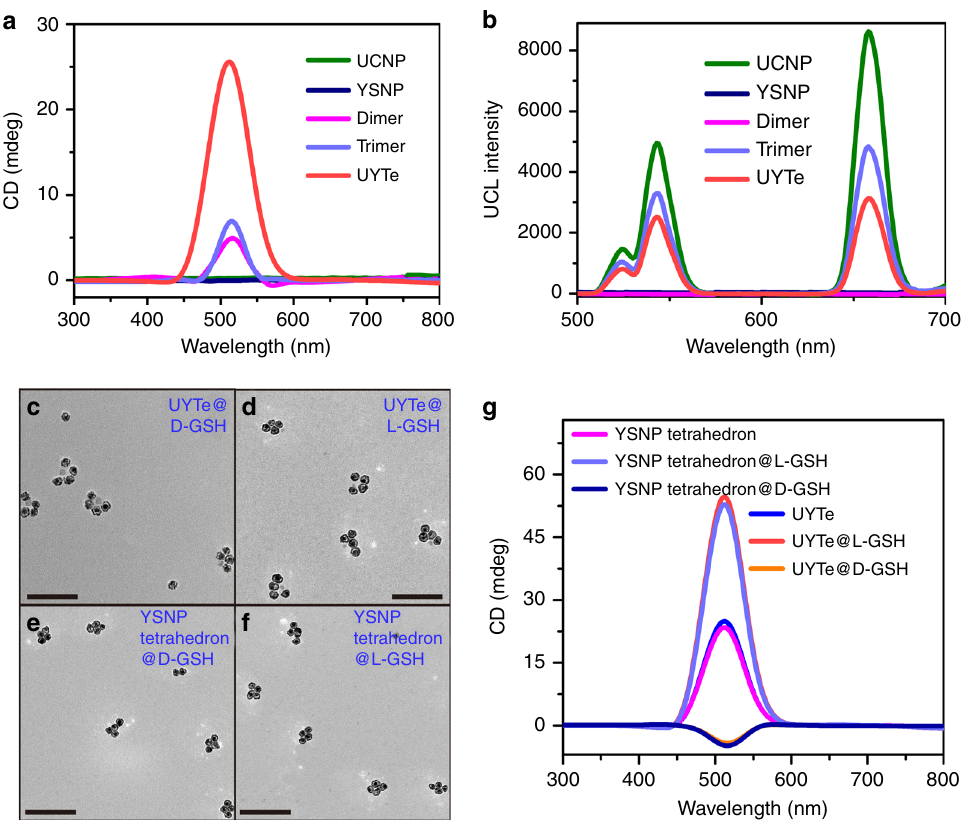
Fig. 3 Spectroscopic characterization of self-assembled chiral nanodevice. The a CD and b UCL spectrum of UCNP, YSNPs, YSNP dimer, YSNP-YSNP- UCNP trimer, and UYTe assemblies. The TEM images of c D -GSH and d L -GSH-modi fi ed UYTe. The TEM images of e D -GSH and f L -GSH modi fi ed YSNP tetrahedrons, scale bar 200 nm. g The CD spectrum of D -/ L -GSH modi fi ed UYTe and YSNP tetrahedrons. All experiments were performed in